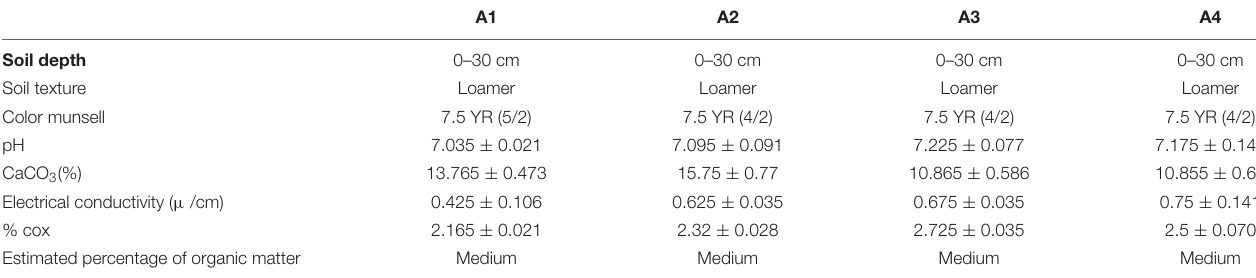
TABLE 2 | Physico-chemical characteristics of the soil at the study